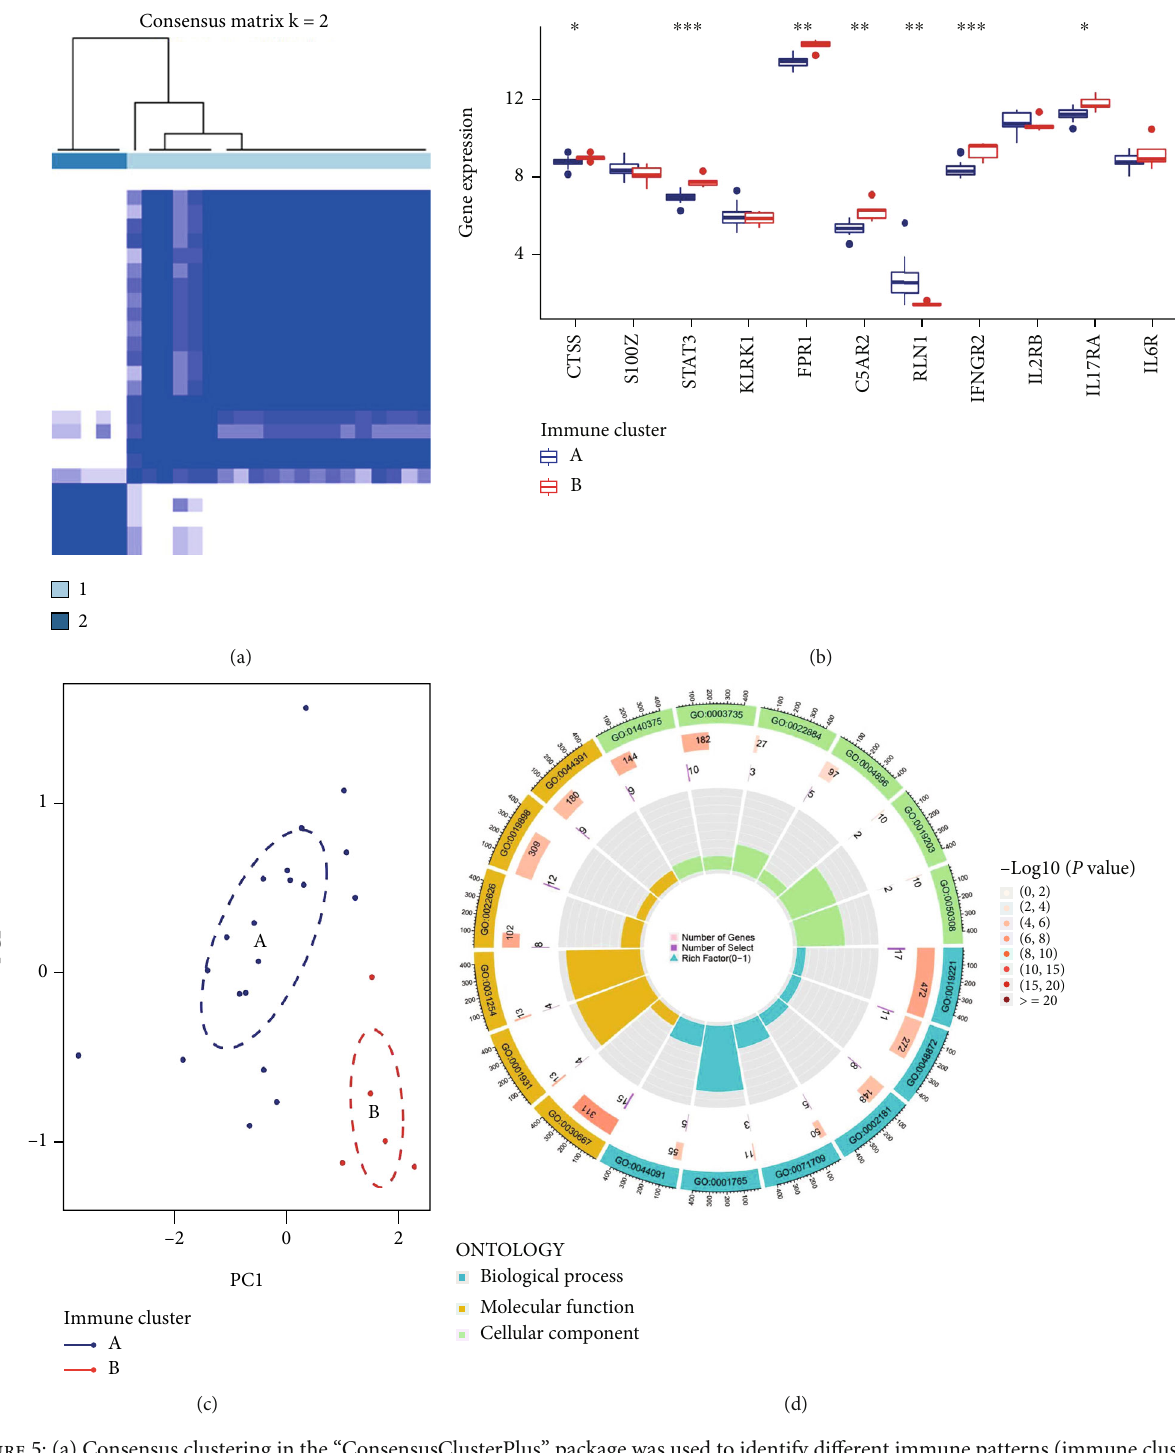
Figure 5: (a) Consensus clustering in the “ ConsensusClusterPlus ” package was used to identify di ff erent immune patterns (immune clusters A and B) on the basis of 11 IRGs. (b) Di ff erential expression levels between the 11 signi fi cant IRGs between the two clusters are shown by histograms, and the results suggested that CTSS, STAT3, FPR1, C5AR2, IFGR2, and IL17RA displayed higher expression levels in immune cluster B than in immune cluster A, while RLN1 showed the opposite. S100Z, KLRK1, IL2RB, and IL6R demonstrated no signi fi cant di ff erences between immune cluster A and B. (c) 11 signi fi cant IRGs can completely distinguished the two patterns by the PCA algorithm. (d) The GO functional enrichment analysis and the enrichment circle plot visualization results were used to understand the possible mechanism of the di ff erent immune patterns in